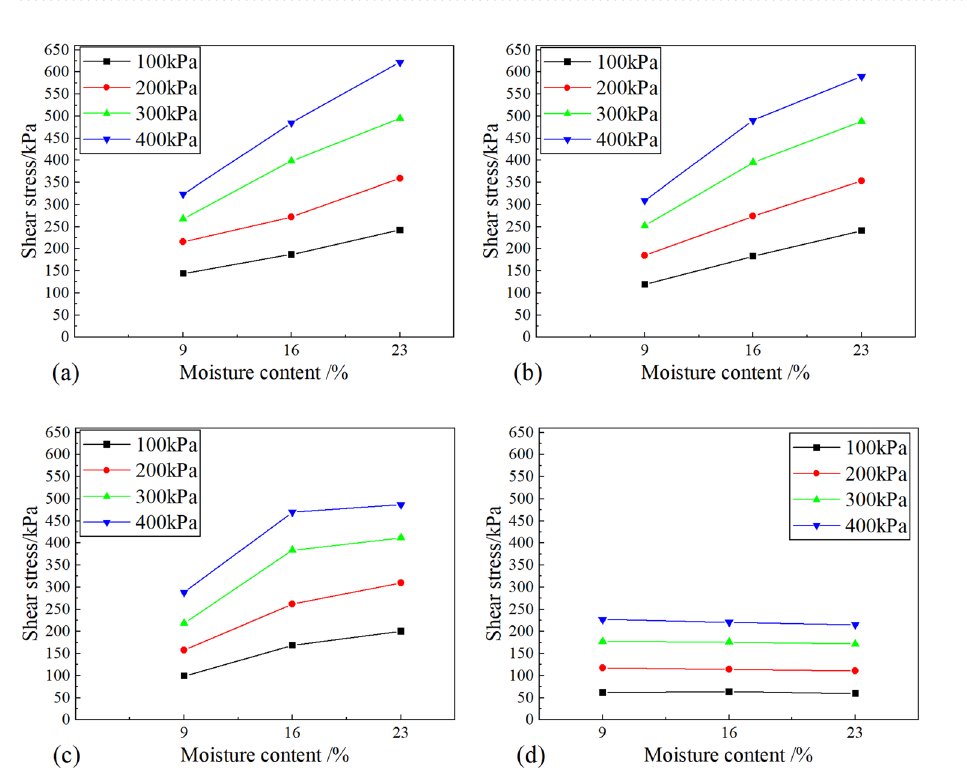
Figure 6. Effect of moisture content on shear strength of soil-ice interface at different shear temperatures:( a ) − 10 ℃ ; ( b ) − 5 ℃ ; ( c ) − 2 ℃ ; ( d ) 0